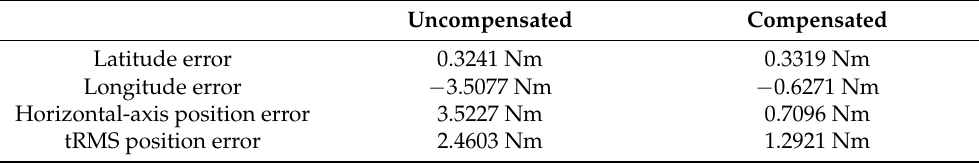
Table 5. Navigation performance of the long-term static state